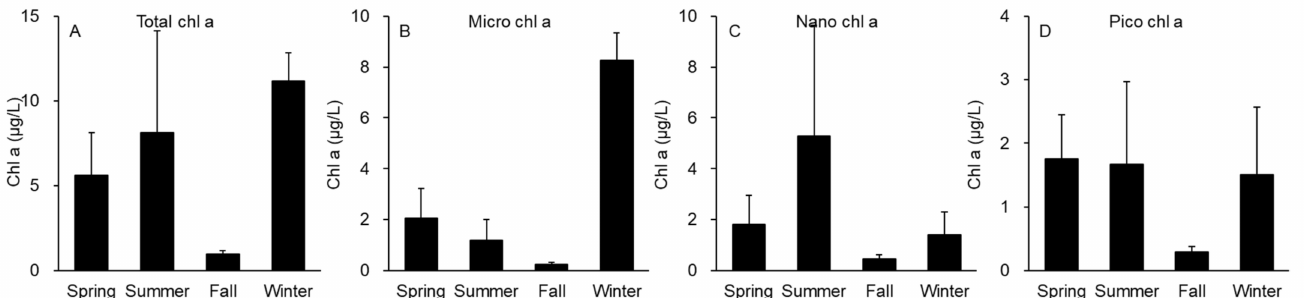
Figure 5. Phytoplankton biomass (chlorophyll a) in Gwangyang Bay: ( A ) total chlorophyll a (chl a), ( B ) microplankton chl a, ( C ) nanoplankton chl a, and ( D ) picoplankton chl